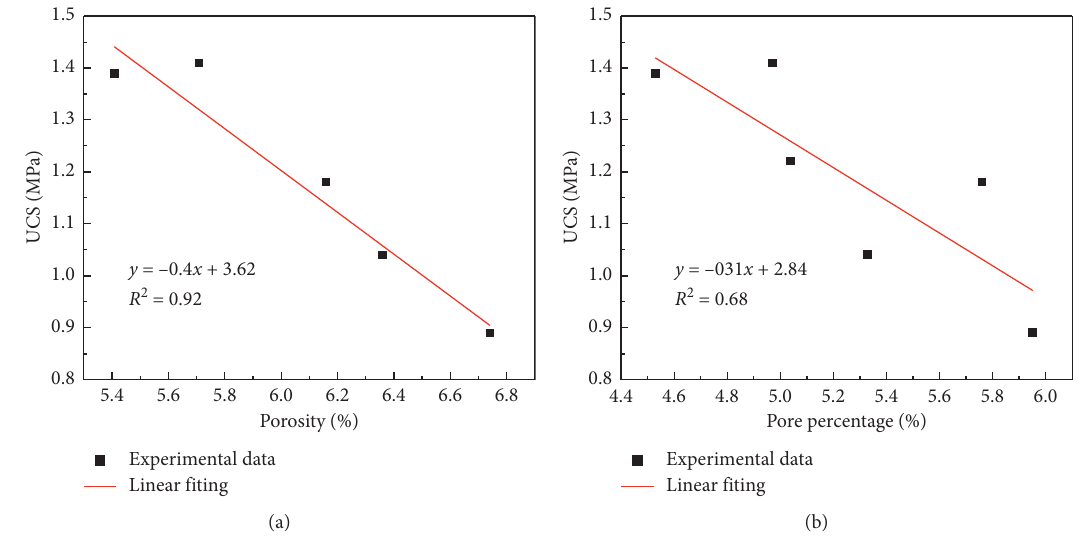
Figure 8: Relationship between strength and porosity and pore percentage.